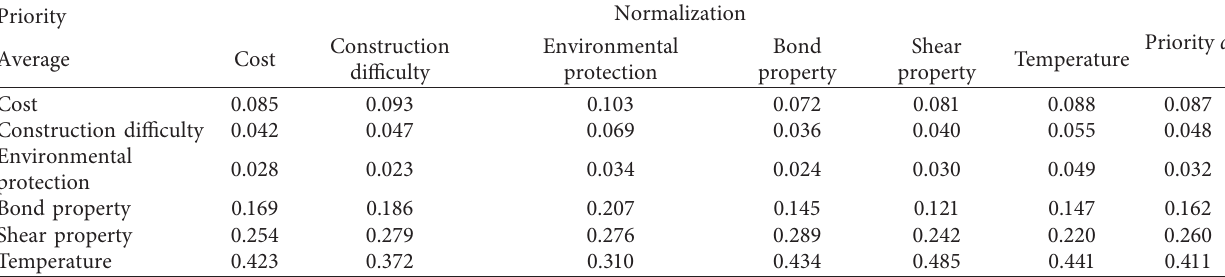
Table 7: Priority normalization of influencing factors of the waterproof adhesive